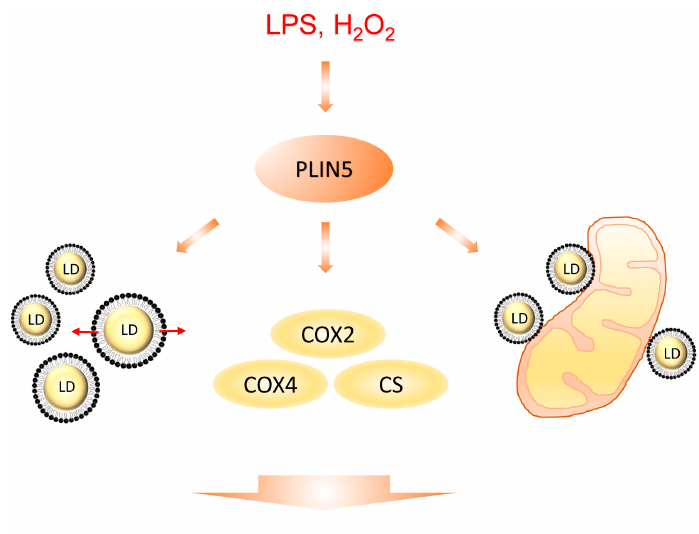
Figure 8. Diagrammatic sketch of this study. PLIN5 was up-regulated by cellular stress induced by H 2 O 2 or LPS treatment. Then, the increased PLIN5 levels promoted cellular LD formation and expansion, expression levels of COXs and LDs contacting with mitochondria. Subsequently, LD formation and expansion reduced the levels of cellular fatty acids, which promoted the alleviation of stress. COXs’ up-regulation reduced the release of cytochrome c from mitochondria to cytoplasm and reduced the mitochondrial damage. The contacts between LDs and mitochondria helped the transfer of potential harmful proteins from mitochondria to LDs. Therefore, cellular stress was alleviated.